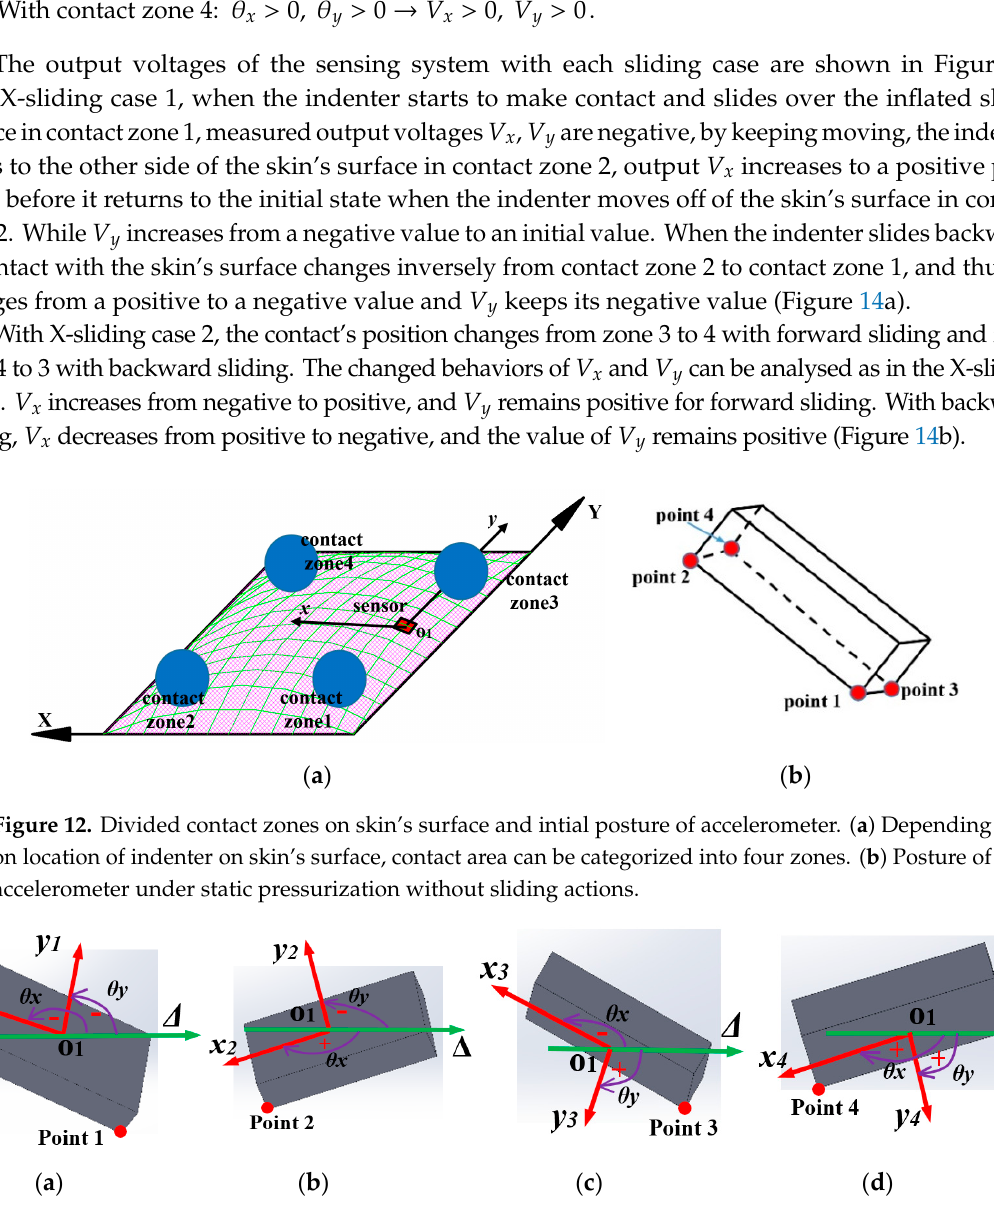
Figure 13. Accelerometer’s posture and its outputs with di ff erent contact zones. ( a ) Contact zone 1: Accelerometer is inclined toward point 1 θ x < 0 → V x < 0, θ y < 0 → V y < 0. ( b ) Contact zone 2: Accelerometer is inclined toward point 2 θ x > 0 → V x > 0, θ y < 0 → V y < 0. ( c ) Contact zone 3: Accelerometer is inclined toward point 3 θ x < 0 → V x < 0, θ y > 0 → V y > 0. ( d ) Contact zone 3: Accelerometer is inclined toward point 4 θ x > 0 → V x > 0, θ y > 0 → V y > 0.